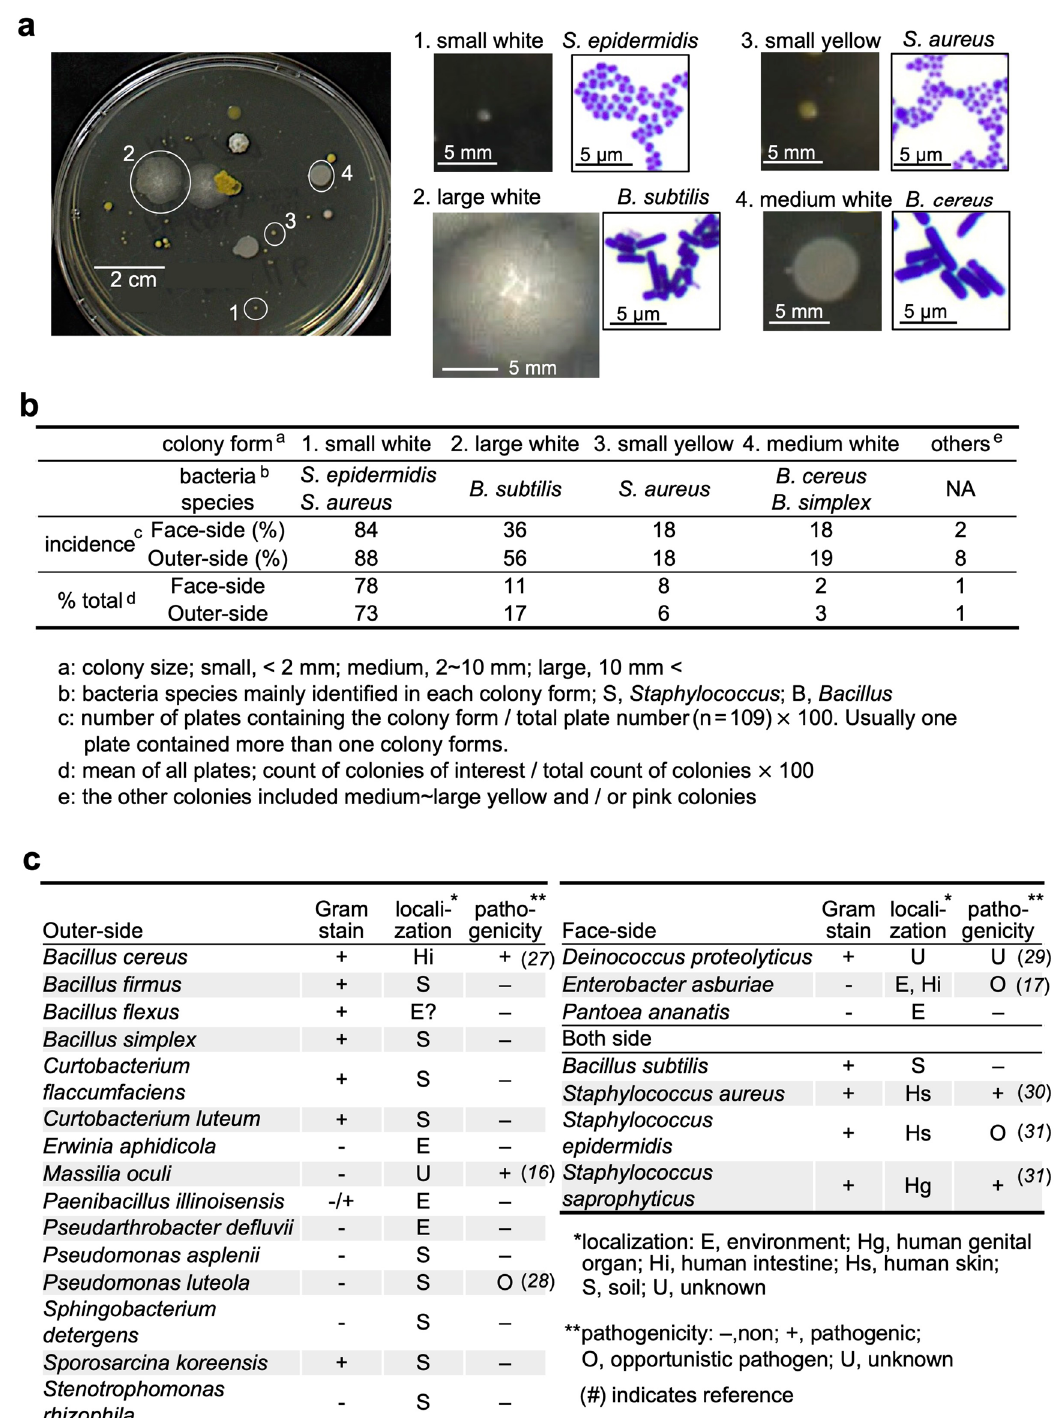
Figure 4. Bacterial colony morphologies and identification. ( a ) We observed a variety of colonies on the agar plates and classified the colonies into four major colony forms, morphologically. Representative bacteria composed of each colony were visualized with their Gram-stain images. ( b ) Major colony forms, identified bacteria, and frequencies (incidence and % total). ( c ) Identified bacteria, their localization, and pathogenicity in